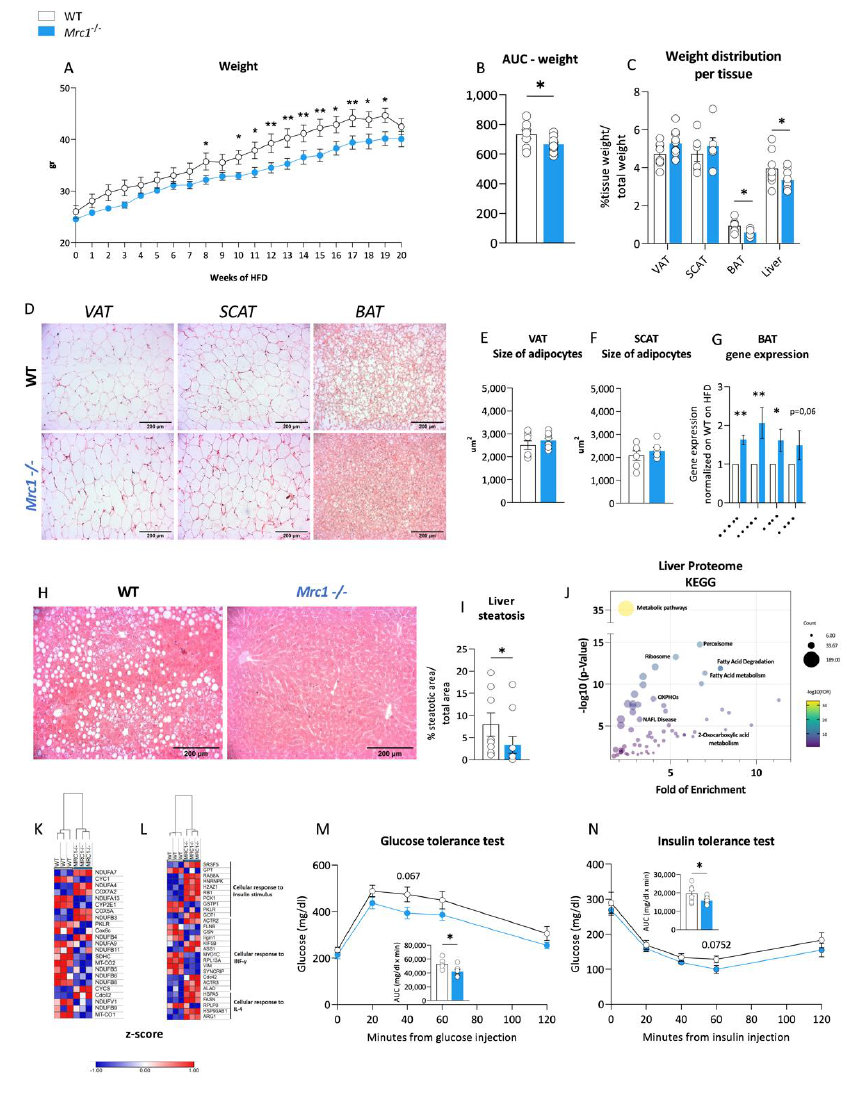
Figure 4. Immune metabolic phenotype of Mrc1 − / − mice and WT mice fed an HFD for 20 weeks. ( A ) Weekly body weight during 20 weeks of high-fat diet feeding for WT and Mrc1 − / − mice; ( B ) area under the curve AUC and ( C ) organ/tissue weight distribution of the VAT, SCAT, BAT, and liver from WT and Mrc1 − / − mice. ( D ) Representative images of hematoxylin and eosin-stained sections from left to right of visceral, subcutaneous, and brown adipose tissues from WT (first row) and Mrc1 − / − mice (second row). The mean area as um 2 of adipocytes within the VAT ( E ) and SCAT ( F ) for both experimental groups are presented. ( G ) Gene expression analysis of Ppara , Pgc1a , Atgl , Ucp1 in BAT from Mrc1 − / − normalized to that of WT. Representative images of hematoxylin and eosin-stained sections of the liver from both experimental groups ( H ) and the prevalence of liver steatosis ( I ) are shown. ( J ) Dot plot showing fold of enrichment ( x -axis) and the –log 10 p -value ( y -axis) of enriched pathways following KEGG database analysis. Hierarchical clustering and heatmap showing relative protein expression values (Z-score transformed LFQ protein intensities) for proteins with significantly different expression in WT and Mrc1 − / − mice (non-alcoholic fatty liver disease, NAFLD ( K ) and other relevant pathways ( L ),FDR < 0.05). ( M ) Glucose tolerance test (GTT) performed at 20 weeks of HFD feeding in WT and Mrc1 − / − mice and calculated AUC. ( N ) Insulin tolerance test (ITT) performed at 20 weeks of HFD feeding in WT and Mrc1 − / − mice and calculated AUC. Blood glucose levels are shown. Glycaemia was measured before i.p. glucose or insulin injection (t = 0, baseline values) and after 20, 40, 60, and 120 min. Results are expressed as mean ± SEM, n = 8–10 mice per group. * p < 0.05; ** p <